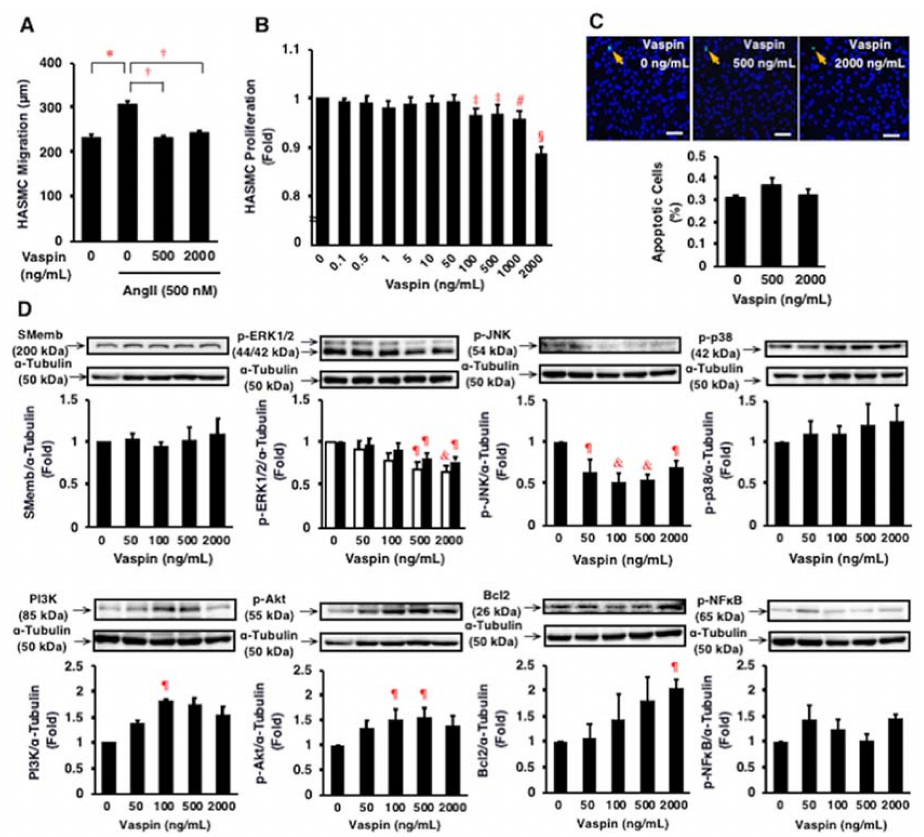
Figure 4. Effects of vaspin on migration, proliferation, apoptosis, and intracellular signal transductions in HASMCs. ( A ) Effect of vaspin on angiotensin II (Ang II)-induced migration was determined in 10 cells per well using a BIOREVO BZ-9000 microscope. The experiments were repeated independently 4 times. * p < 0.005, † p < 0.0001. ( B ) Effect of vaspin on proliferation was determined by WST-8 assay ( n = 4). ‡ p < 0.05, # p < 0.001, § p < 0.0001 vs. 0 ng/mL of vapin. ( C ) Effect of vaspin on apoptosis was evaluated by detecting apoptotic cells (green) using the TUNEL method. Nuclei were co-stained with 6-diamidino-2-phenylindole (blue). The graph indicates the percentage of apoptotic cells in 3 independent experiments. Bar = 100 µ m. ( D ) Relevant intracellular signals in response to vaspin were assessed by immunoblotting. The blotted membranes were cut for reacting with different antibodies, and the blots were stripped and reprobed in the same membrane. Top: Representative results of protein expression/phosphorylation of SMemb, ERK1/2, JNK, p38, PI3K, Akt, Bcl2, and NF κ B. Bottom: Densitometric data of each molecule after normalization relative to α -tubulin ( n = 4–5). ¶ p < 0.05, & p < 0.01 vs. 0 ng/mL of vapin (corresponding